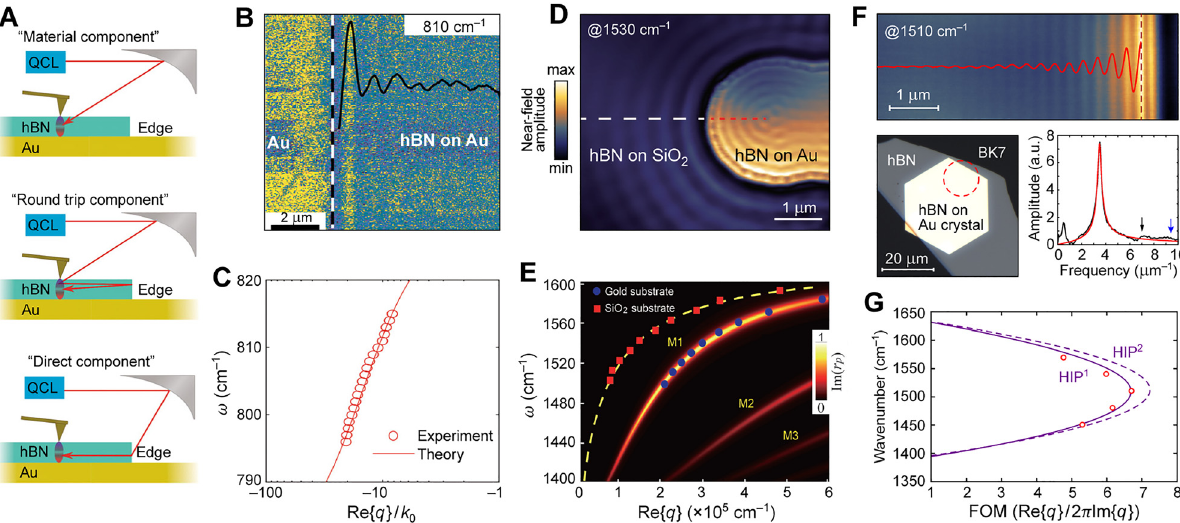
Figure 7: Near-field probing of image phonon-polaritons in hBN. (A) Different components of the near-field signal detected by s-SNOM when scanning the hBN edge on gold. (B) Near-field map of the hBN edge measuredbyPiFMinthefirstreststrahlenbandRS1;theblacksolidlineindicatestheprofileofthenear-fieldinterferencefringesformedbyimage phonon-polaritonsupon their reflectionby the hBN edge. (C) Dispersion of imagephonon-polaritonsin a hBN slab obtained fromthe PiFM near- fi eld maps in RS1. (A) – ( C)Adapted with permission from[21]. Licensedundera Creative Commons Attribution. (D) Near- fi eld map of the phonon- polaritonsinhBNpartially coveringthegoldpad, measuredby s-SNOMintheRS2band. (E)Dispersionof phonon-polaritonsinhBNonSiO 2 and imagemodesinhBNongold,obtainedintheRS2bandbys-SNOMasshownin(D).(D)and(E)Adaptedwithpermissionfrom[20].Copyright2017, Wiley. (F) Near- fi eld probingof the imagepolaritonsinhBNongold crystal (bottomleft); thestraight edgeof the gold crystal launchespolaritons with planar wavefront (top), so that their complex propagation constant can be recovered from the Fourier spectrum of the interference fringes (bottom right). (G) Measured (data points) and calculated (solid) FOM of the image polaritons in hBN; perfect agreement between the experimental and analytical data demonstrates the absence of scattering loss due to the atomically smooth surface of the gold crystals